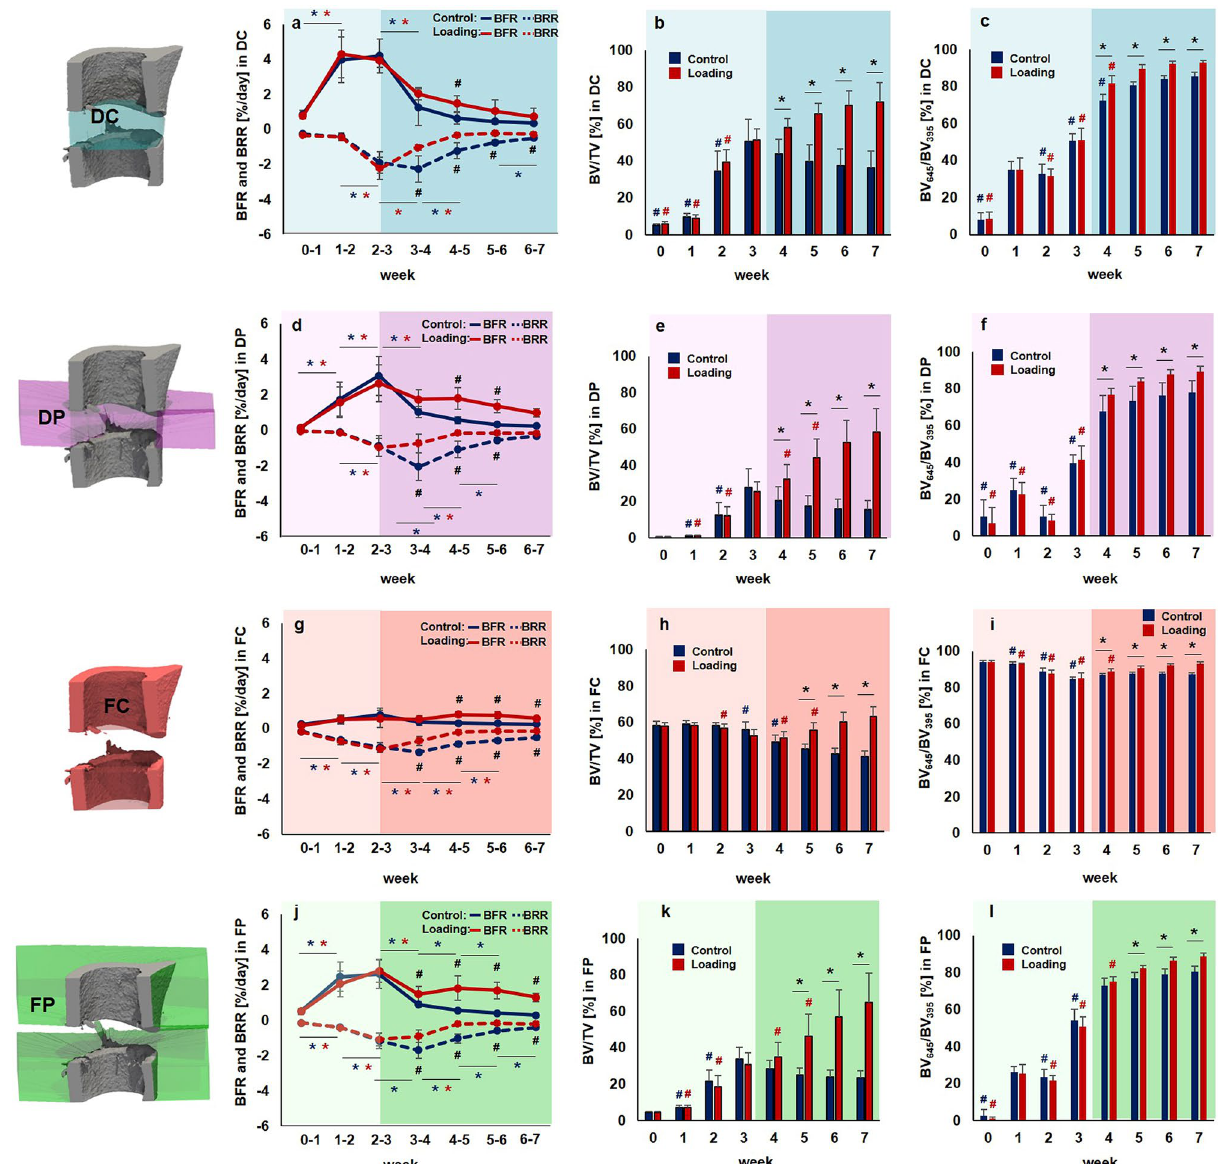
Figure 3. Micro-CT based evaluation of bone parameters in the defect region during the healing period. Four volumes of interest (VOIs) were assessed in the loading group (red) and the control group (blue) from week 0 to week 7 (pre-loading healing period highlighted in lighter colour; loading period highlighted in darker colour): defect center (DC; a - c ), defect periphery (DP; d - f ), cortical fragment center (FC; g - i ), cortical fragment periphery (FP; j - l ). a , d , g , j : Bone formation rate (solid line) and bone resorption rate (dashed line) given in percent per day. b , e , h , k : Bone volume (BV) normalized to TV (DC for DC and DP, FC for FC + FP). c , f , i , l : Degree of bone mineralization given as ratio of bone volume with a density ≥ 645 mg HA/cm 3 to the total osseous volume (threshold ≥ 395 mg HA/cm 3 ). n = 10 per group; *indicates p < 0.05 determined by two-way ANOVA with Geisser-Greenhouse correction and Bonferroni